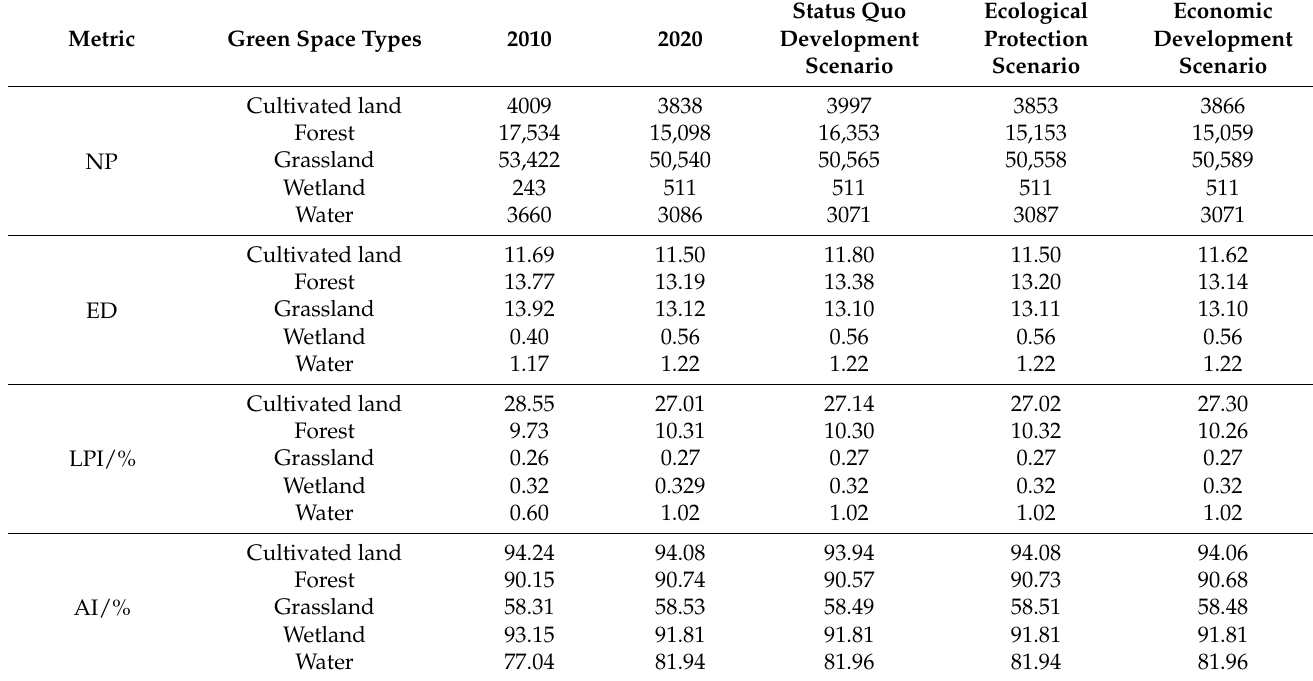
Table 4. Class-level